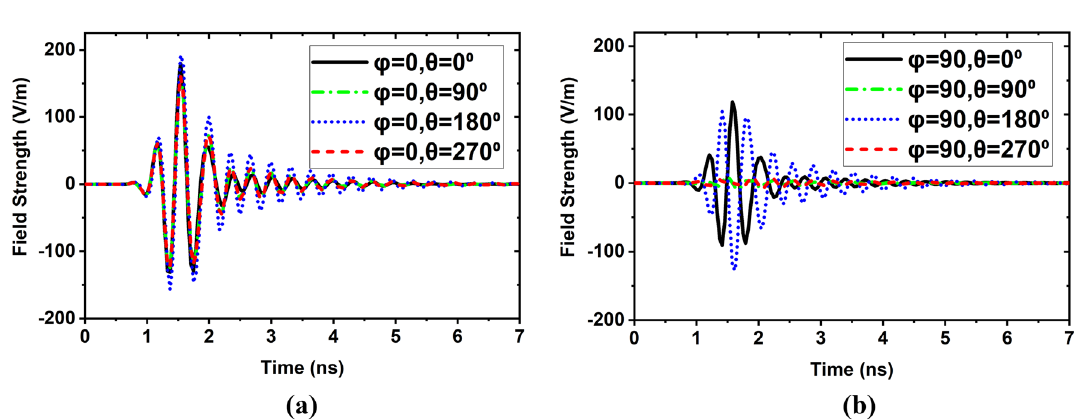
Figure 12. Simulated and measured radiation pattern in E-plane and H-plane of the proposed antenna at: ( a ) 2.24 GHz; ( b ) 2.66 GHz; ( c ) 2.84 GHz; ( d ) Measured near-field in H-plane at 2.24 GHz, 2.66 GHz, and 2.84 GHz.